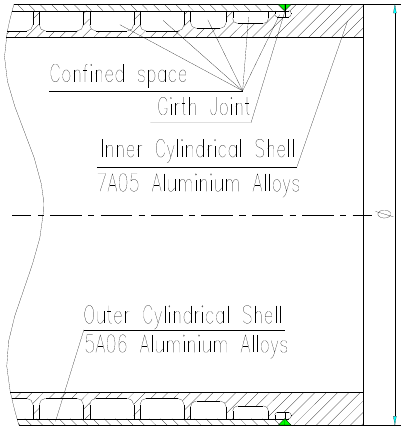
Figure 1. Sample structure sketch.